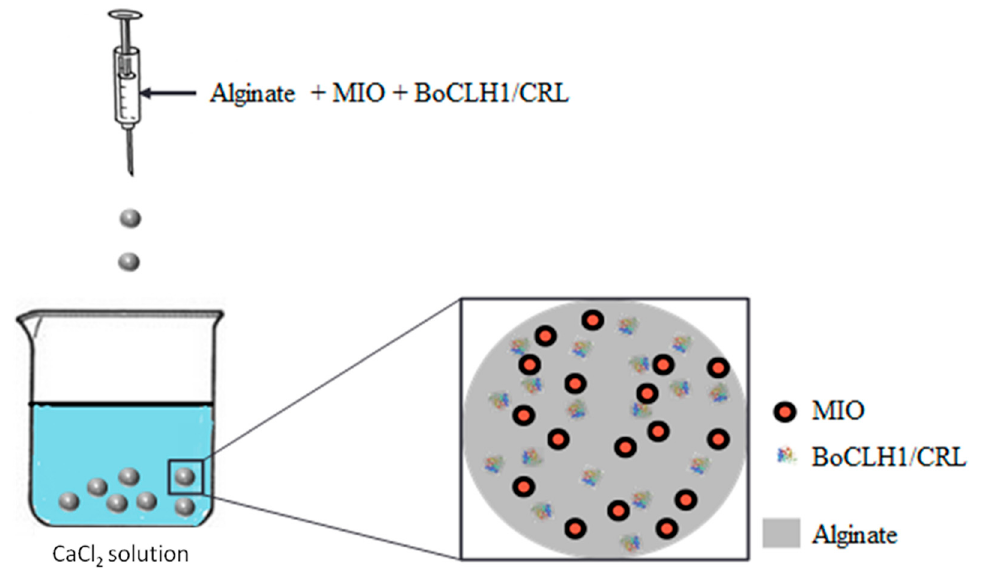
Figure 1. Schematic diagram showing the synthesis of enzyme encapsulated magnetic alginate composite beads. The MIO is magnetic iron oxide (Fe 3 O 4 nanoparticles); The BoCLH1 is Brassica oleracea chlorophyllase 1; The CRL is Candida rugosa